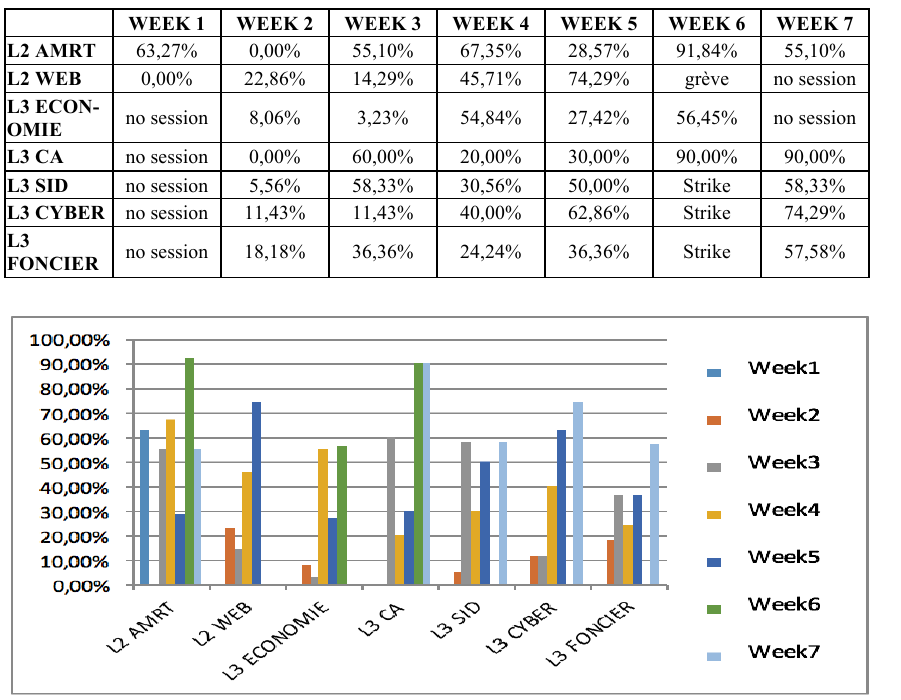
Fig. 4. Comparison of weekly connection rates for all